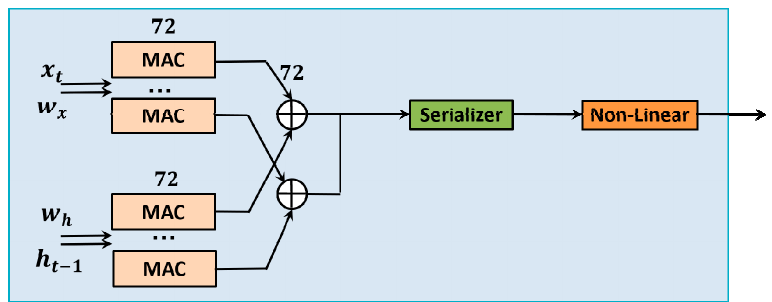
Figure 9. The computing architecture of the neural network in edge components. RNN, recurrent neural network.